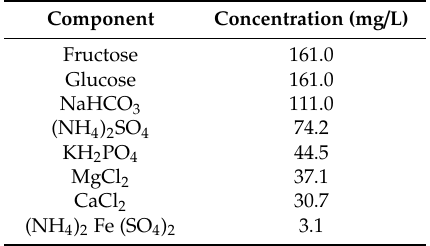
Table 1. Characteristics of the synthetic